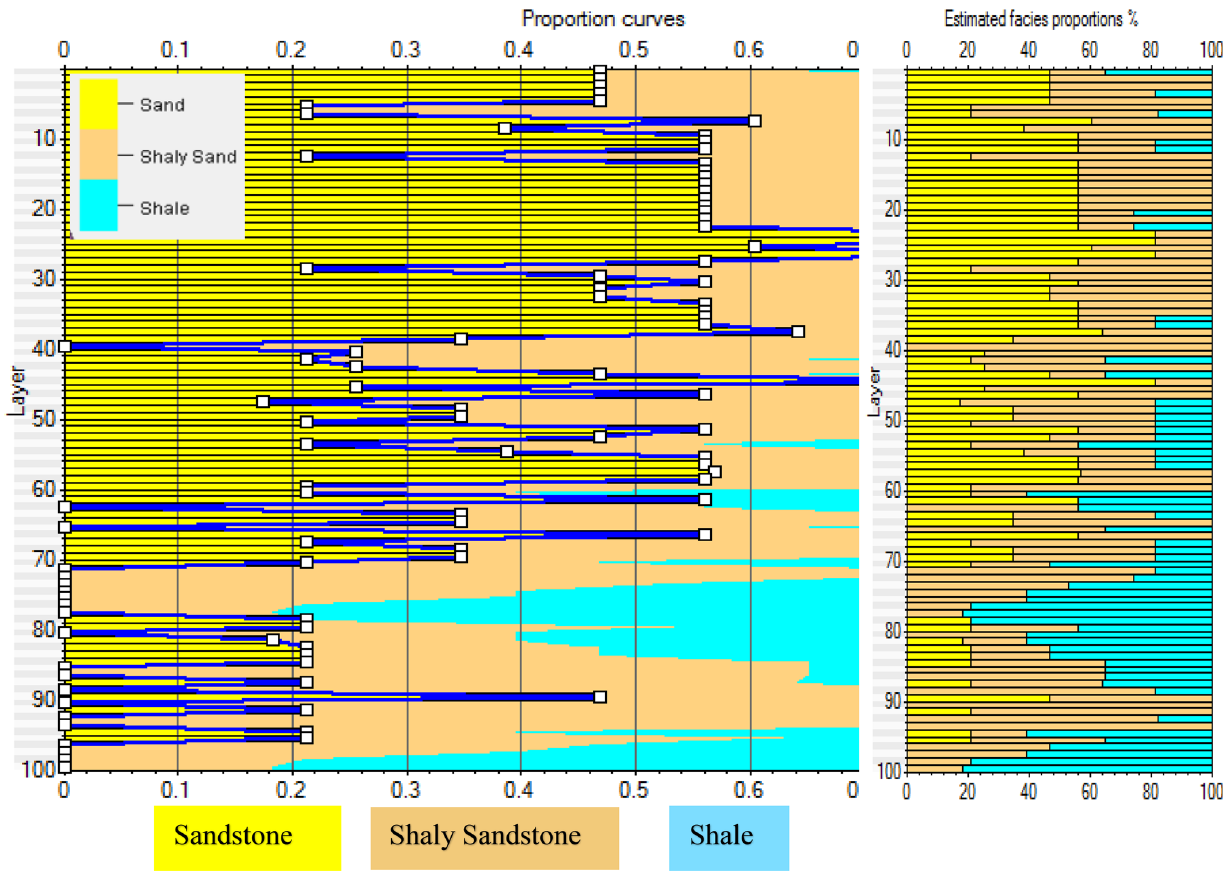
Fig. 6 Data analysis of facies